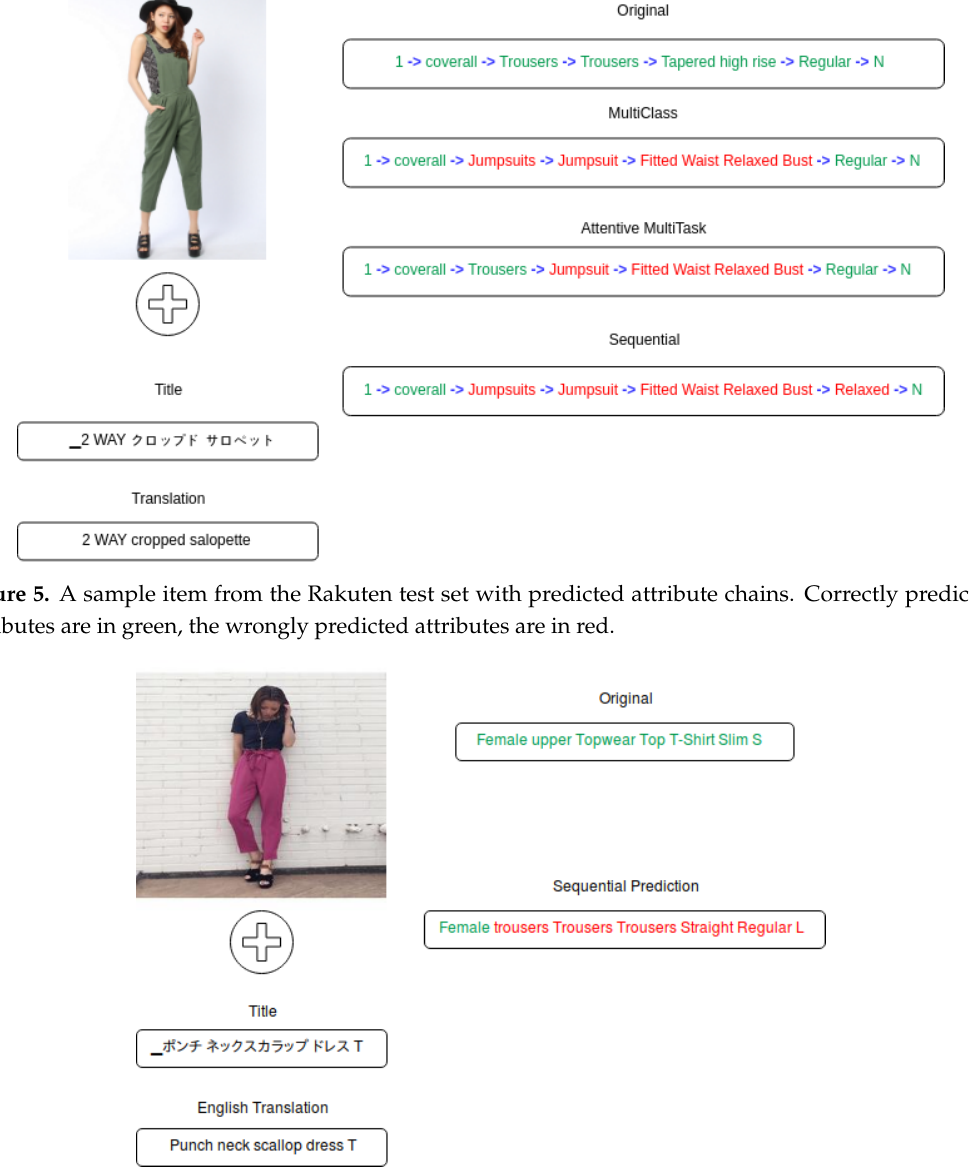
Figure 6. A sample item from the Rakuten test set, where the original attribute chain is annotated for top dress, but the model focuses on bottom dress attributes. Correctly predicted attributes are in green, the wrongly predicted attributes are in